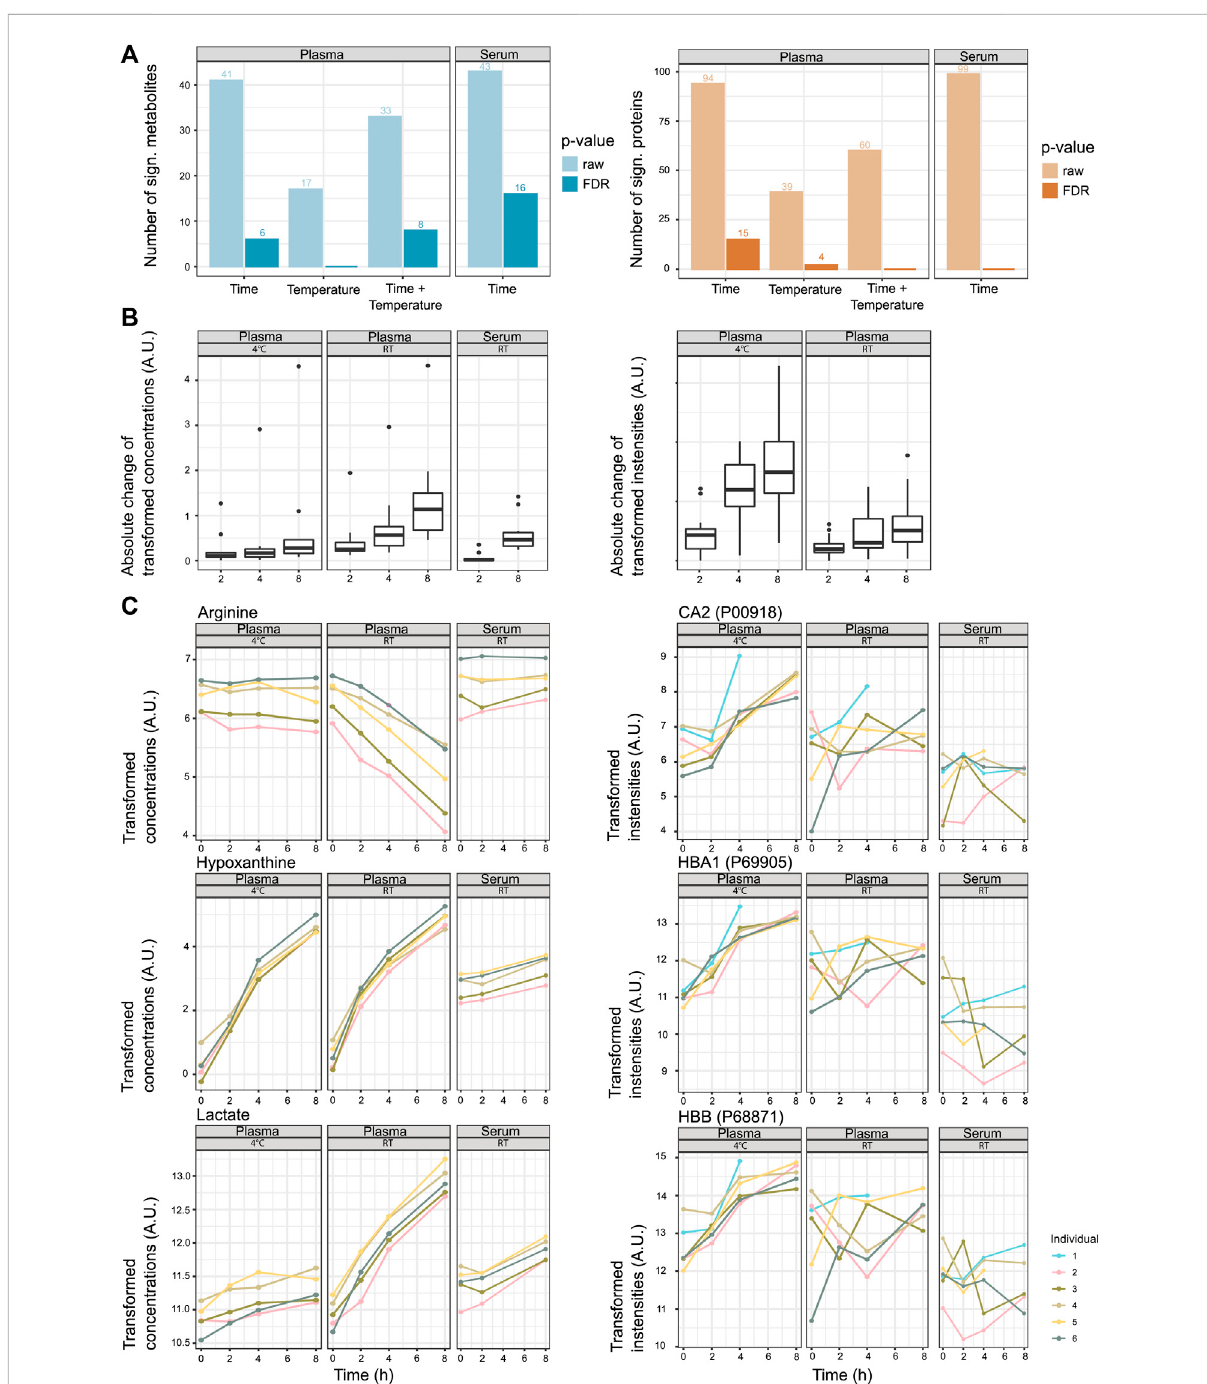
FIGURE 2 Stability of metabolites and proteins along the sitting time and temperature axes. (A) Number of signi fi cant metabolites or proteins that show changes according to pre-analytical factors time , temperature , and the interaction time/temperature (raw p -values and p -values after FDR correction, α < 0.05). (B) Absolutechangeoftransformedconcentrations/intensitiesofsigni fi cantmetabolitesandproteinsalongthetimeaxis(afterFDRcorrection).Thechangesto the time points 2, 4, and 8 h are displayed as the mean changes of the individuals (intensity at time point 0 h is 0). For plasma, the features that are signi fi cant for the pre-analytical factors time , temperature , or the interaction time/temperature ( α < 0.05, FDR correction) are included. For serum, the featuresthataresigni fi canttothepre-analyticalfactor time ( α < 0.05,FDRcorrection)areincluded.Fortheproteomicsdatasetandserum,nofeatureswere signi fi canttothepre-analyticalfactor time ,andthepanelisomitted. (C) Examplesofmetabolitesandproteinsthatshowasigni fi cantassociationwiththepre- analytical factor time (hypoxanthine, lactate, CA2, HBB, and HBA1) or interaction time/temperature (lactate and arginine) ( α < 0.05, after FDR